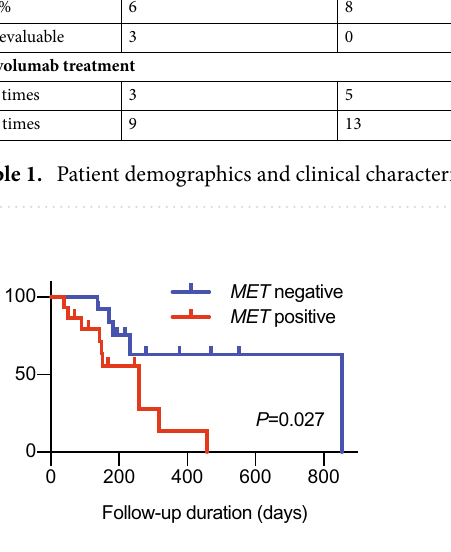
Figure 1. The expression of MET in CTCs and correlation with clinical outcome in R/M HNSCC patients treated with nivolumab. The Kaplan–Meier curve and log-rank test for overall survival were performed to compare the differences between patients with MET -positive CTCs and those with negative